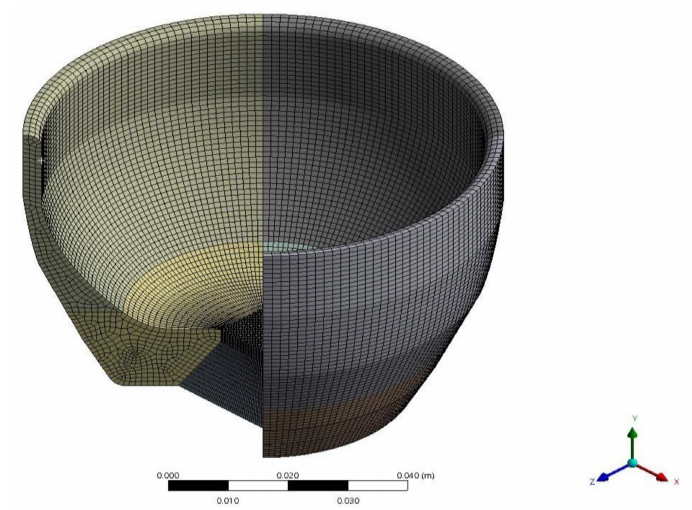
Figure 14. Meshed model of Case 3, Model 1.